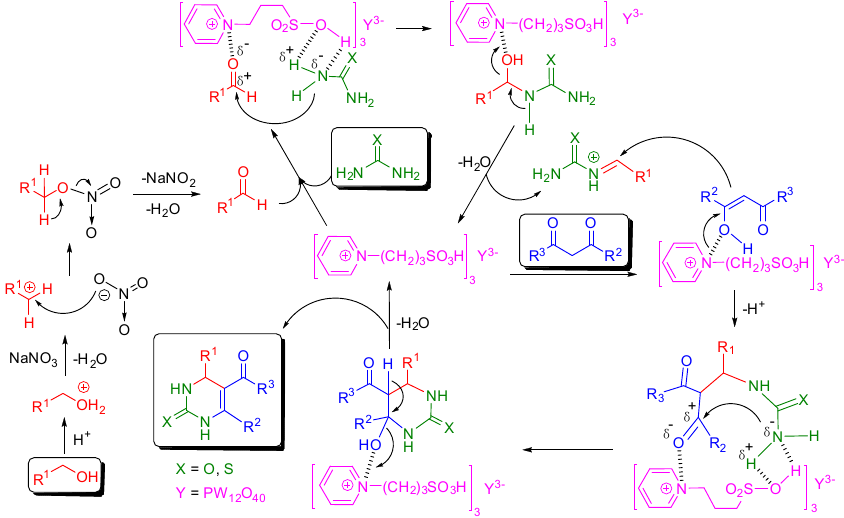
Figure 3. Plausible mechanism of HPAIL catalyzed Biginelli reaction.